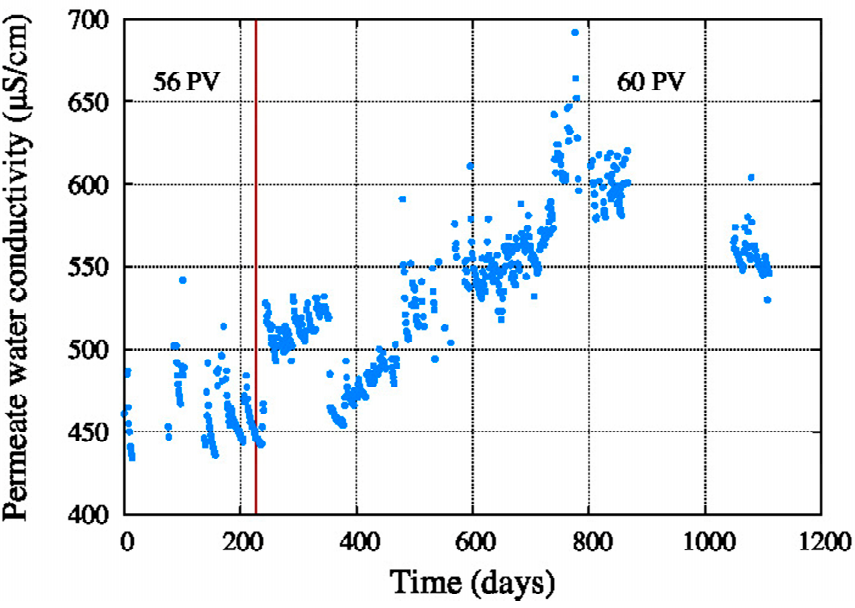
Figure 8. Permeate conductivity. Figure 8. Permeate